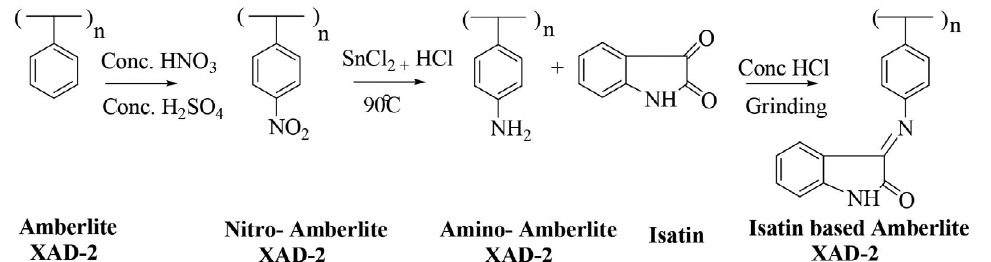
Figure 1. Reaction Scheme for Synthetic Modification of Amberllite XAD-2